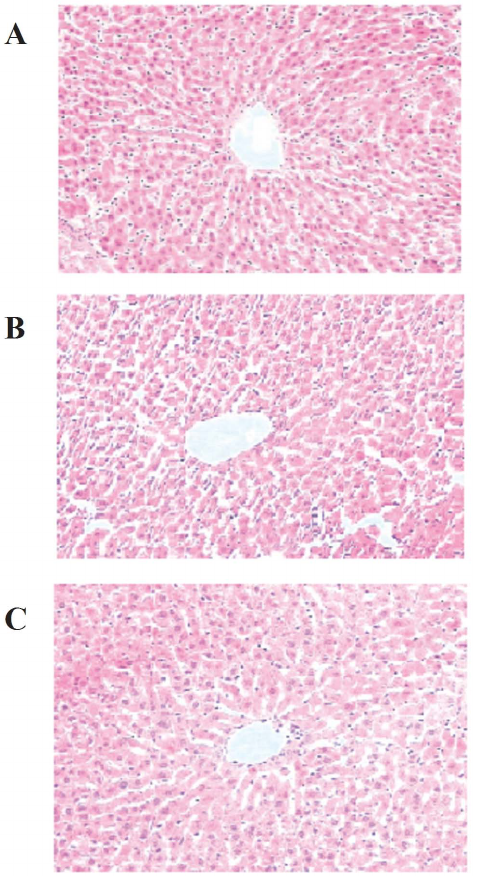
Figure 2. TEM of liver tissue. A and B, control group; C, one week exercise-training group; D, one week stimulating group; E, three weeks exercise-training group; F, three weeks stimulating group; G, five weeks exercise-training group; H, five weeks stimulating group.